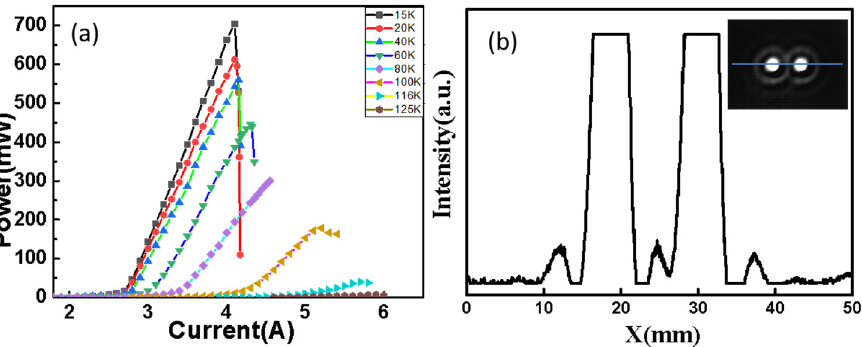
Figure 4. Pulsed P–I characteristics of dual ridge THz quantum cascade laser from 15 K to 125 K and light spot observed at 15 K. ( a ) Pulsed P–I characteristics of dual ridges; ( b ) Far-field patterns intensity distribution of dual ridges.